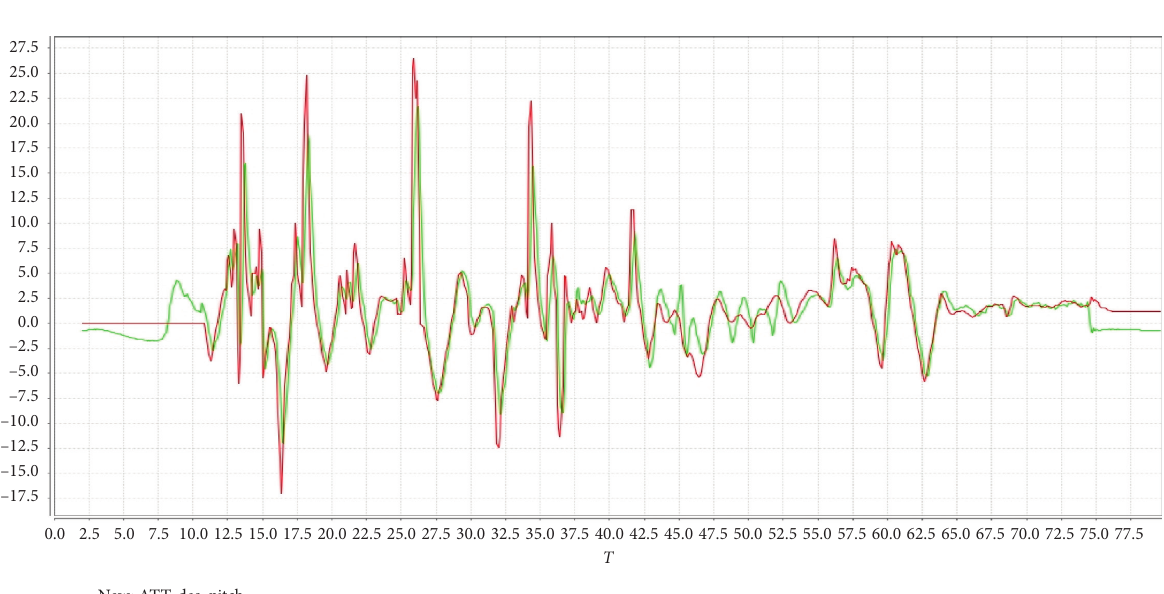
Figure 12: Actual flight pitch angle